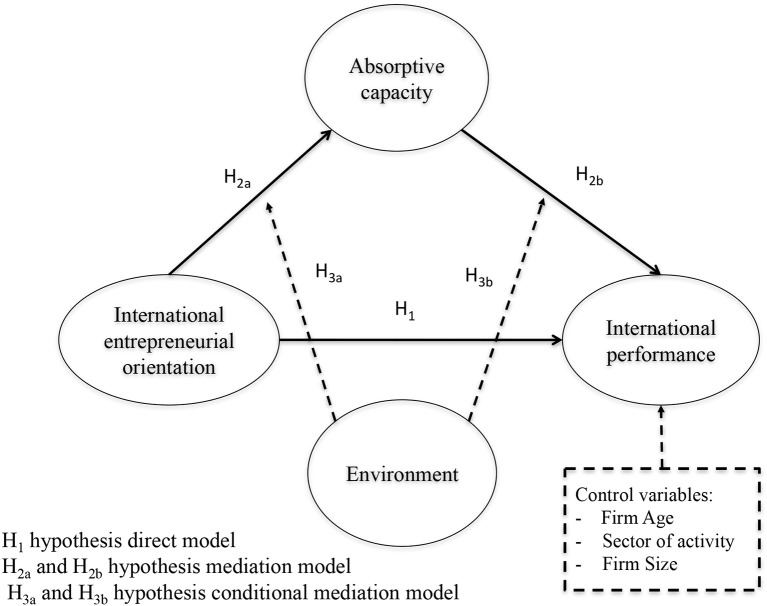
Structural model.